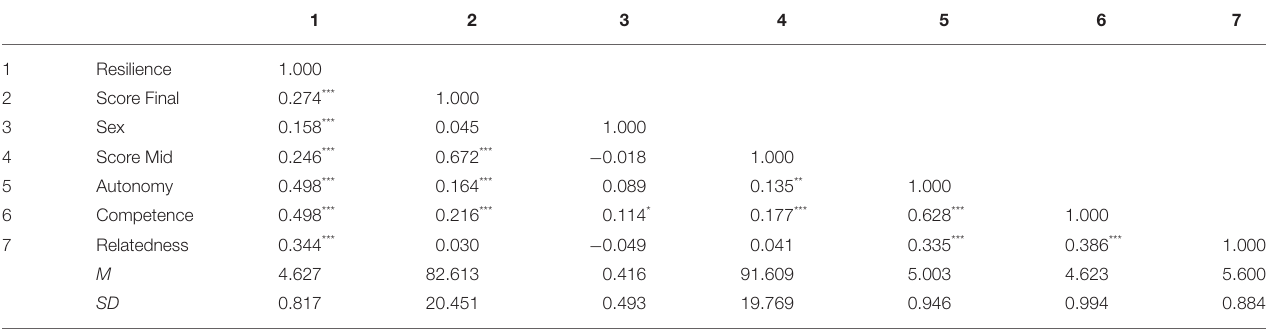
TABLE 1 | Correlations and descriptives of the target variables.